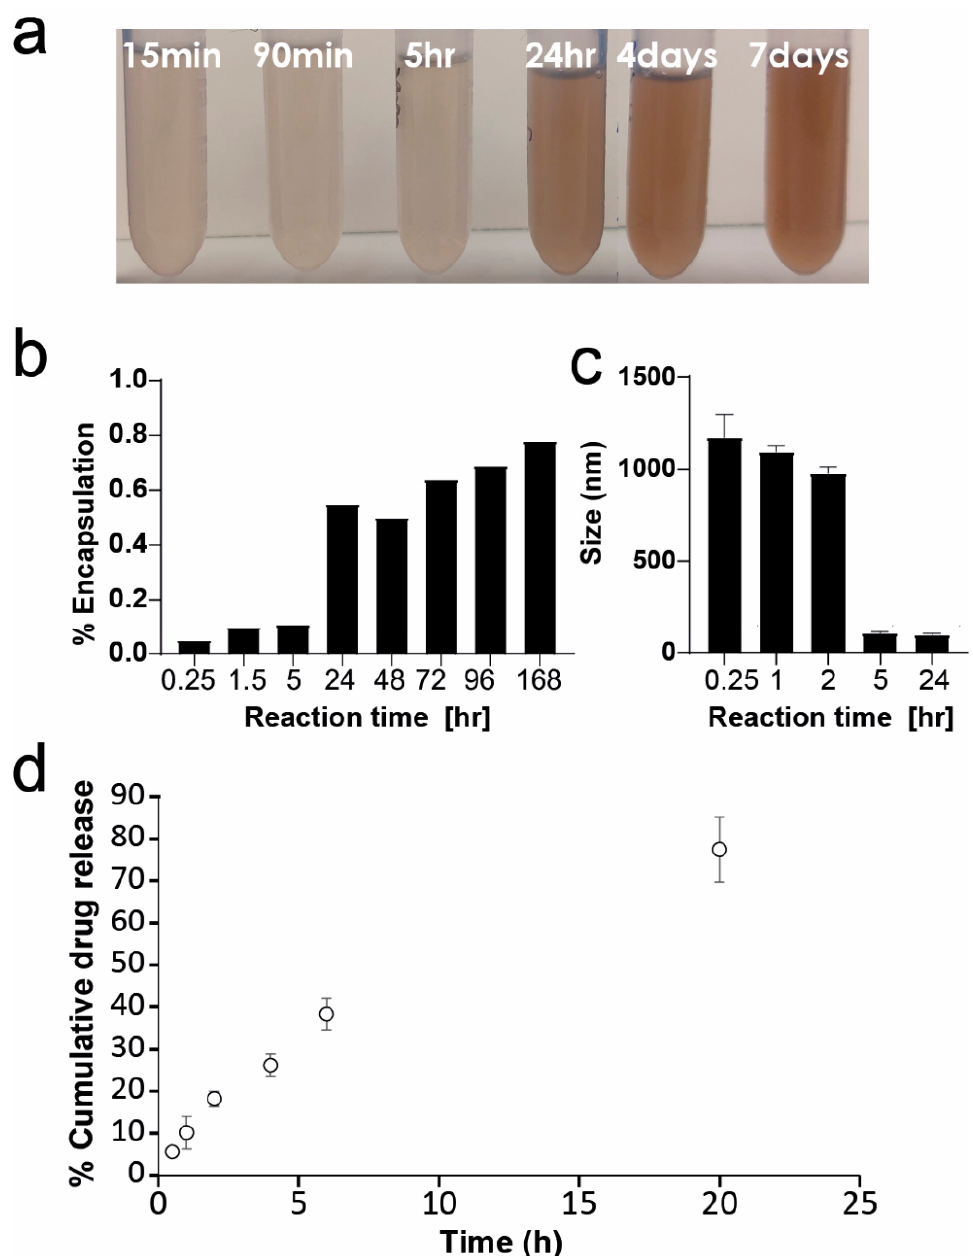
Figure 5. Characterization and optimization of PDA-PDO-In820. ( a ) Nilotinib nanoparticles formulated during different periods of time since polymerization initiation. ( b ) Encapsulation ratios of nilotinib nanoparticles from ( a ). ( c ) Size of ponatinib nanoparticles formulated in different time points during the aging process of PDA-PDO-In820. ( d ) Cumulative drug release profile of ponatinib nanoparticles using PDA-PDO-In820. Error bars represent standard